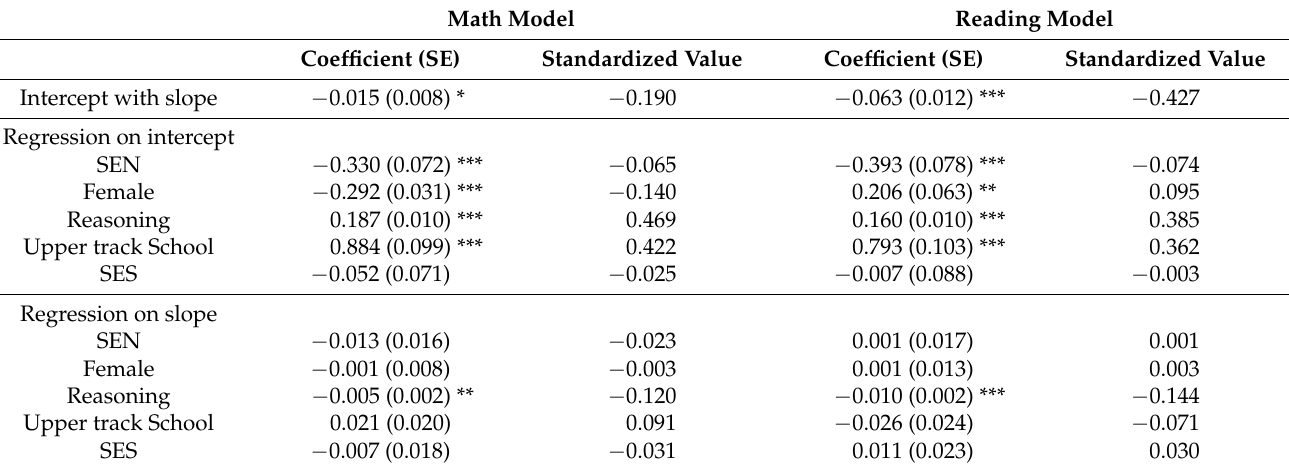
Table 4. Path coefficients—no mediation